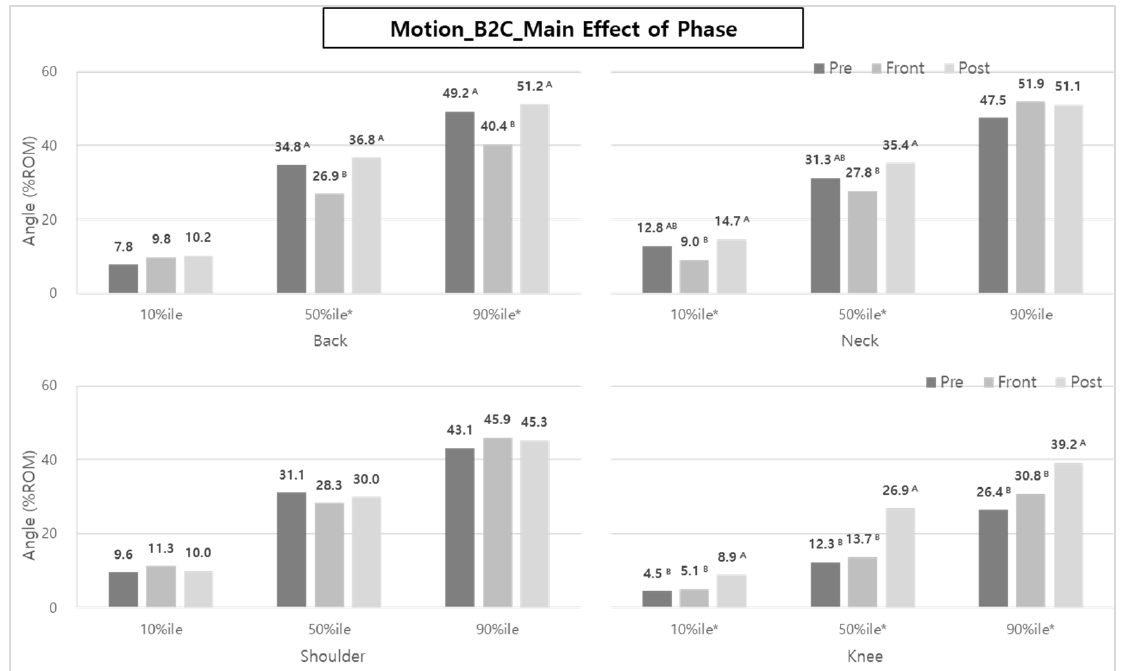
Figure 13. The effect of phase on body posture during B2C. Asterisk (*) and the alphabet capital letter (A and B) indicate that the difference between means is statistically significant at p < 0.05. In the knee posture analysis, the ROMs, 8.9, 26.9, and 39.2% for the 10th, 50th, and 90th %ile during the Post-phase, were highest among the other phases, followed by those of the Front-phase (5.1, 13.7, and 30.8% ROMs) and Pre-phase (4.5, 12.3, and 26.4% ROMs). In general, the %ROM when MC was applied across all task stages was greater than when RC was used, as shown in Figure 14. In particular, in the case of the knee, there were no significant differences in % ROMs between phases in the case of RC (4.9, 4.9, and 6.1% ROMs; 12.7, 5.5, and 16.3% ROMs; 27.8, 29.4, and 29.7% ROMs for the 10th, 50th, and 90th %iles, respectively), whereas in the case of MC, the %ROMs of the knee were rapidly increased from Pre-phase to Front-phase (about 1.4 times) and from Front-phase to Post-phase (about 2.2